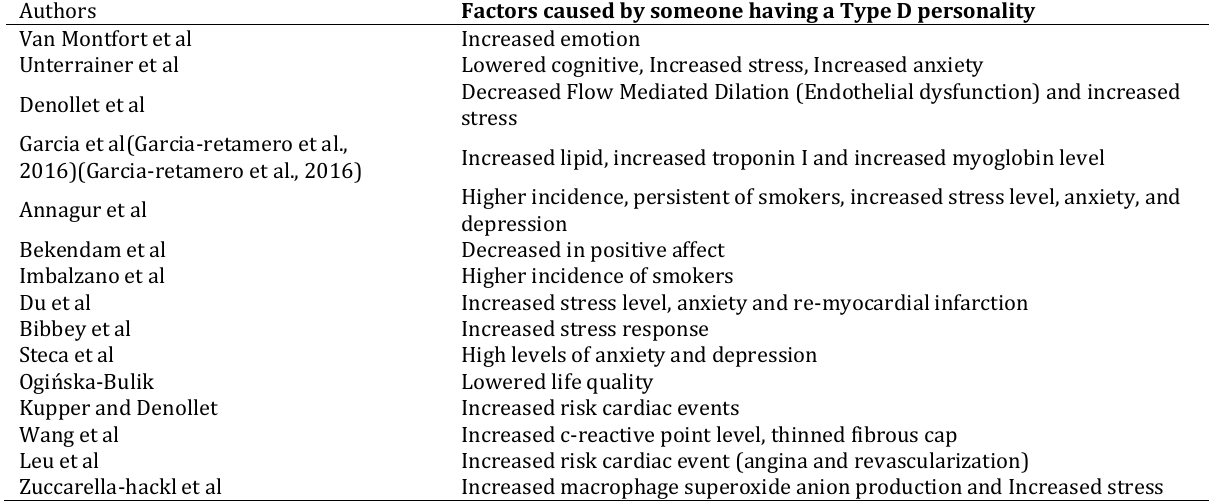
Table 1. List of factors caused by someone having a type D